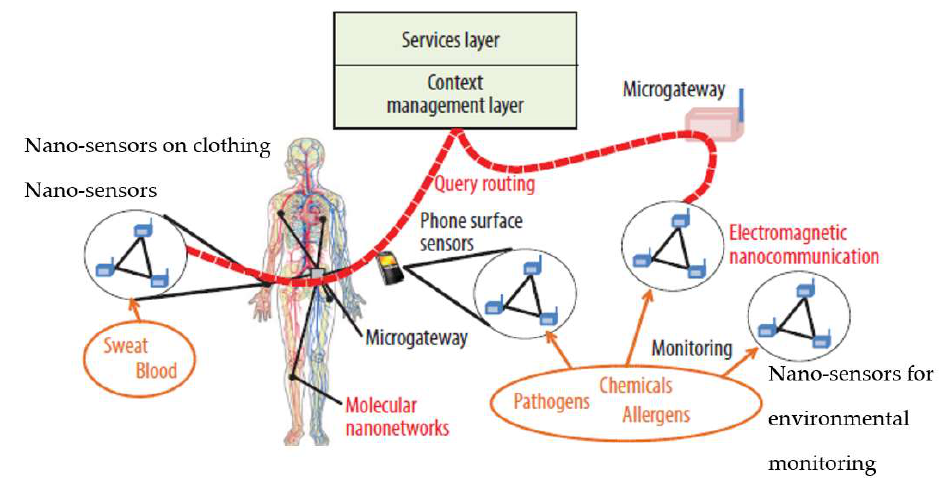
Figure 6. The Internet of Nano-Things. Adapted from [25].